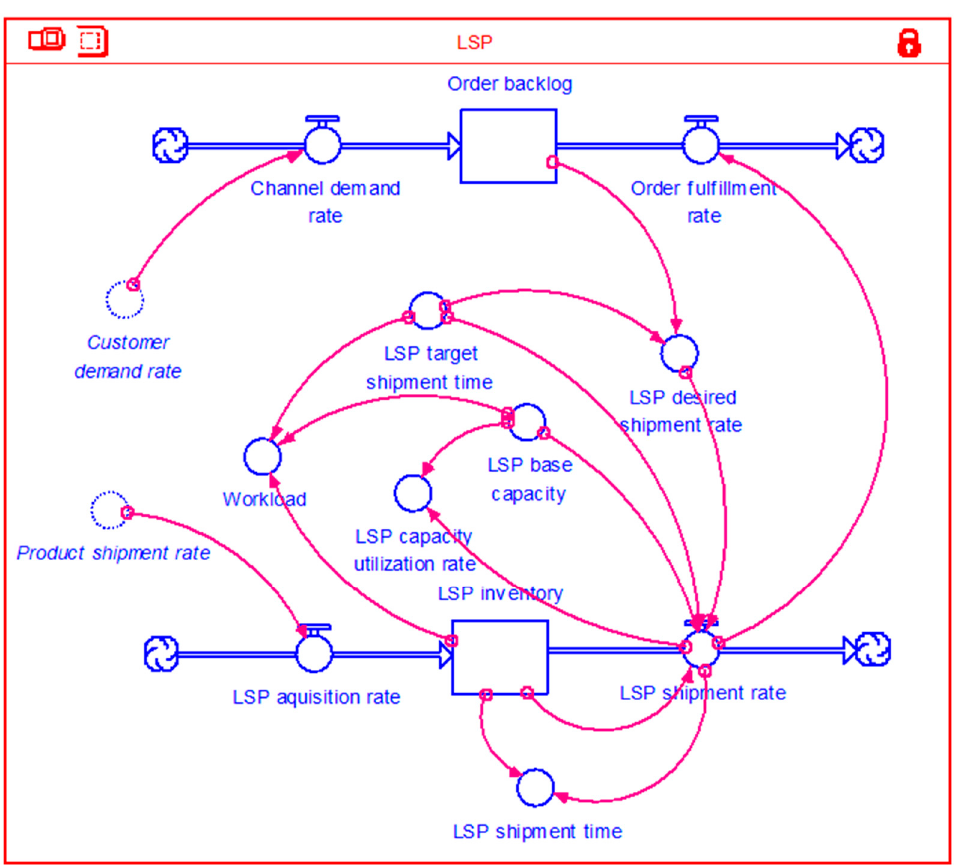
Figure 2. logistics service provider (LSP)’s operation simulation model for Scenarios 1 and 2.